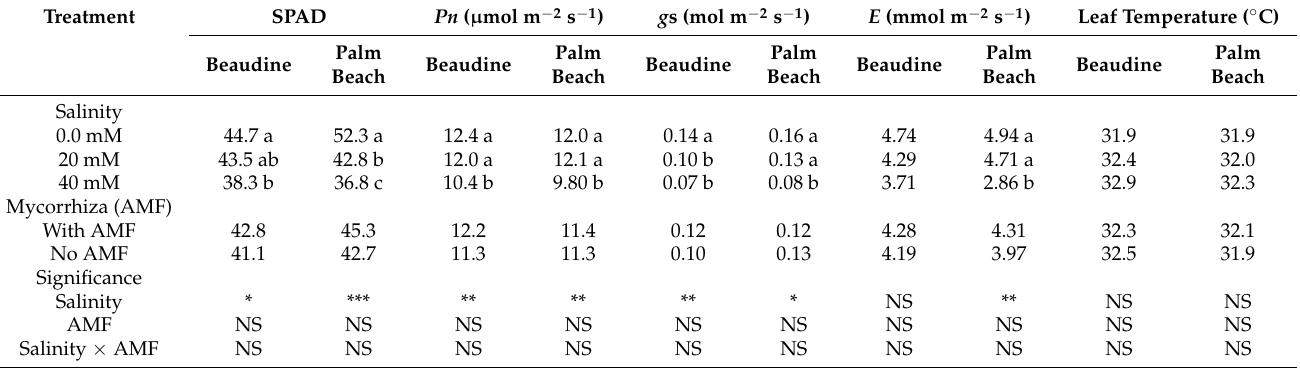
Table 1. Chlorophyll content index (SPAD), gas exchange [photosynthesis ( Pn ), stomatal conductance ( g s), and transpiration ( E )] and leaf temperature of gerbera cultivars (‘Beaudine’ red; ‘Palm Beach’ yellow) inoculated (AMF) or uninoculated (No AMF), grown under different salt stress levels in 2018.